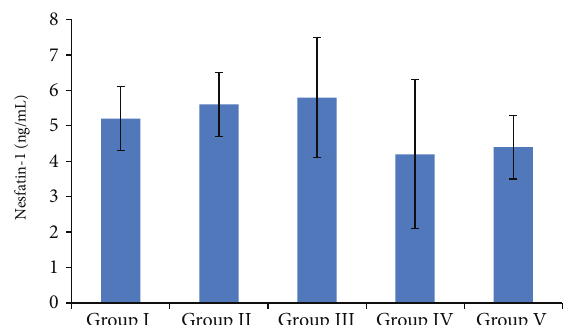
Figure 4: Serum nesfatin-1 levels in relation to BMIs. Group I: low- weight; Group II: normal-weight; Group III: overweight; Group IV: obese;GroupV:morbidlyobese. 𝑃 < 0.005 forGroupIversusGroup IV and Group